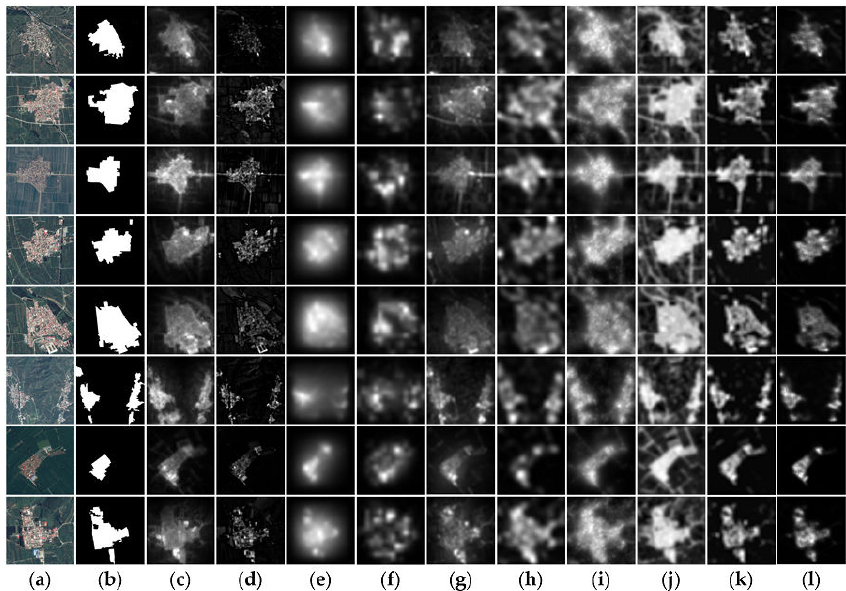
Figure 6. Saliency maps by our proposed model and nine competing models on Google Earth images. ( a ) Origin images; ( b ) Ground truth; ( c ) CA; ( d ) FT; ( e ) GBVS; ( f ) ITTI; ( g ) WT; ( h ) SR; ( i ) MFF; ( j ) SACH; ( k ) FDA and ( l )